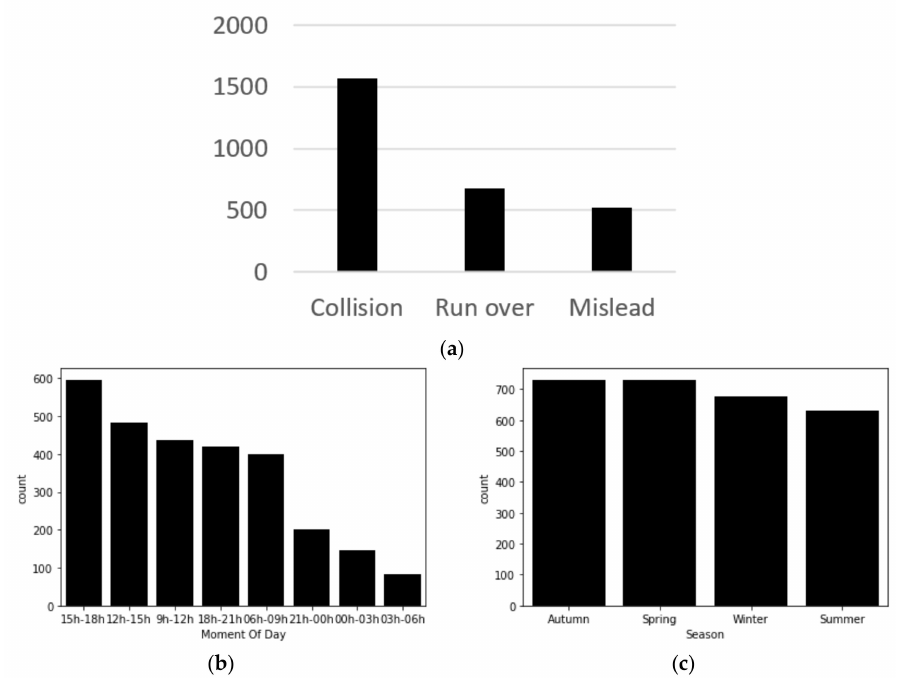
Figure 6. ( a ) Distribution of road accidents by type—collision, runover, and misleading; ( b ) road accident count by time of the day; ( c ) road accident count by season.